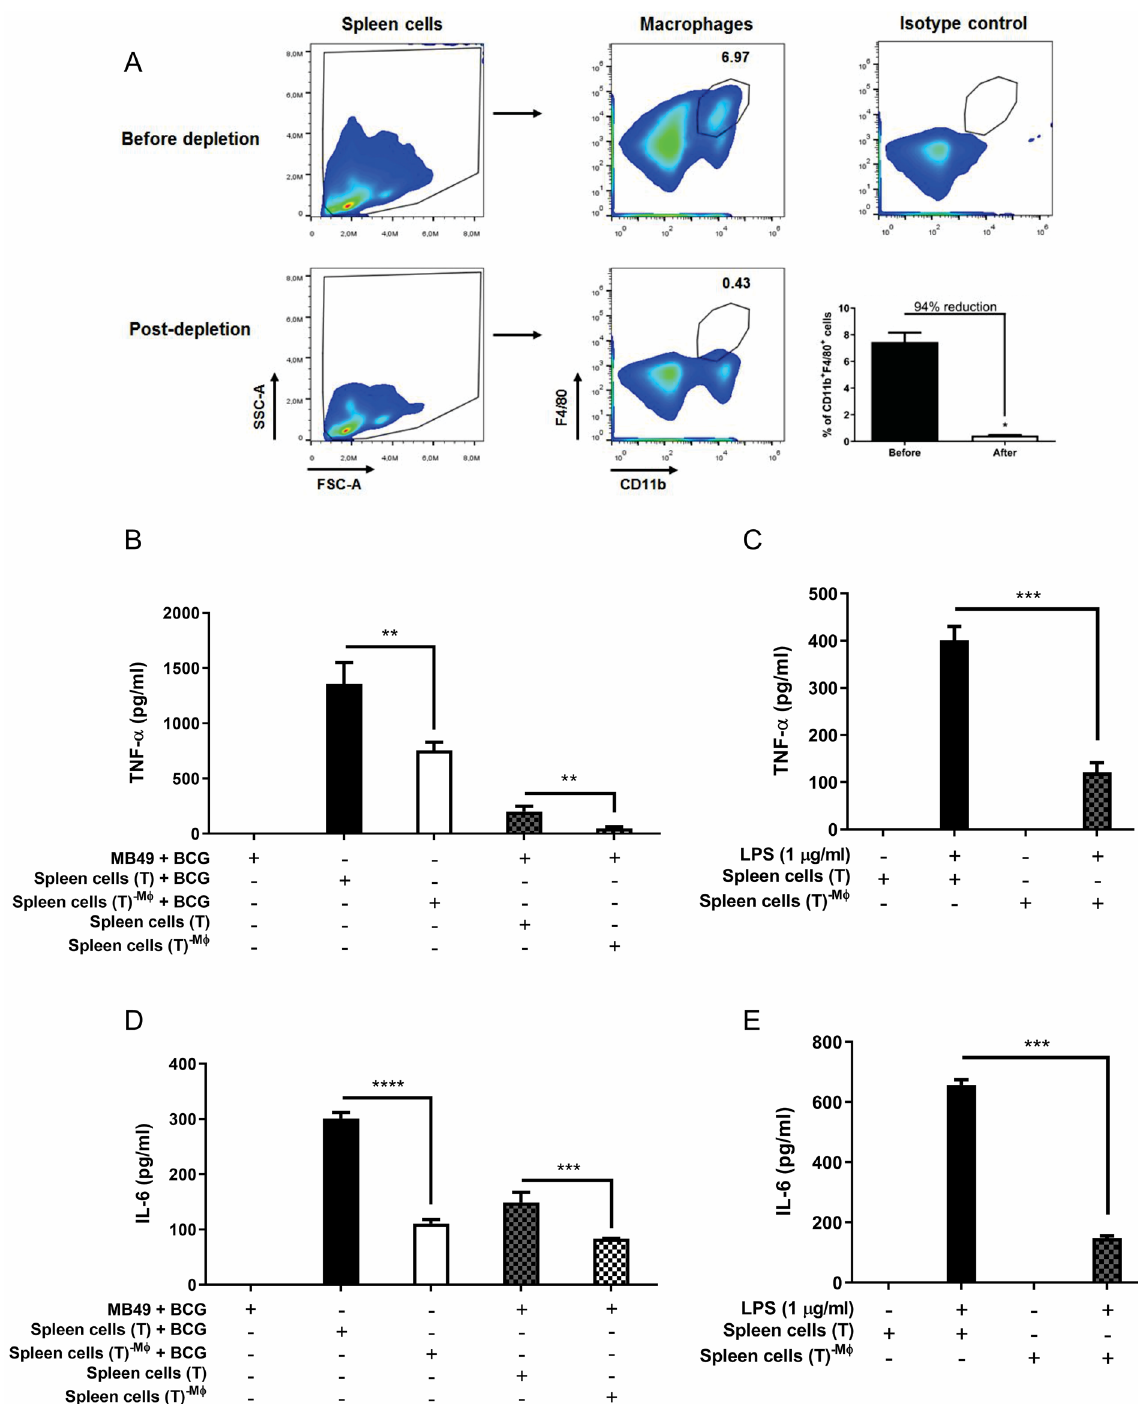
Figure 9. Co-culture performed with macrophages-depleted spleen cells reduces proinflammatory cytokines production. Spleen cells were obtained from mice submitted to the subcutaneous tumor model and treated with BCG (T) after 22 days post-tumor injection. CD11b + F4/80 + cells (Macrophages—MØ) were depleted from the spleen cells (T) using anti-PE MicroBeads kit described in the methodology. The percentage of depletion (94%) was addressed by flow cytometry. ( A ) A representative plot and frequency are shown. Total spleen cells (T) or macrophages-depleted spleen cells (T) −MØ suspension were used for co-culture in vitro with infected MB49 cells (1 MB49 cell: 2 spleen cells). MB49 cells used for co-culture were previously infected with BCG (MB49 + BCG) for 24 h and washed to remove free BCG in the supernatant. ( B , D ) Co-cultured cells were maintained together for 24 h. MB49 or spleen cells were also infected separately (not in co-culture) and used as controls. ( C , E ) Spleen cells were also stimulated with LPS (1 µg/ml) for 24 h as controls. TNF-α ( B , C ) and IL-6 ( D , E ) cytokines production were measured in the supernatants after 24 h by ELISA. The values are representative of two independent experiments. *Statistically significant compared to spleen cells (T) before macrophage depletion. ** P ≤ 0.01, *** P ≤ 0.001, **** P ≤